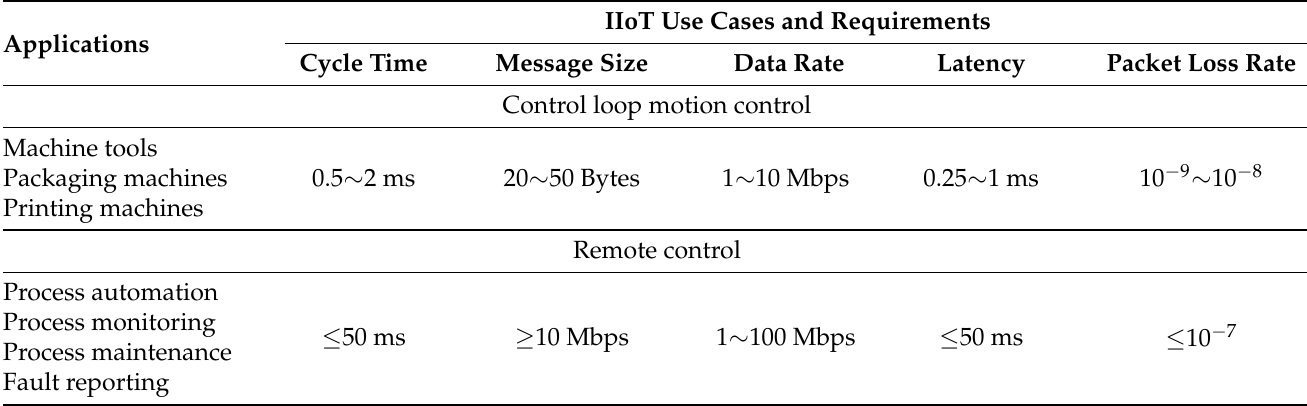
Table 4. Tactile IIoT use cases requirements specifications and characteristics supporting by proposed IoTactileSim.